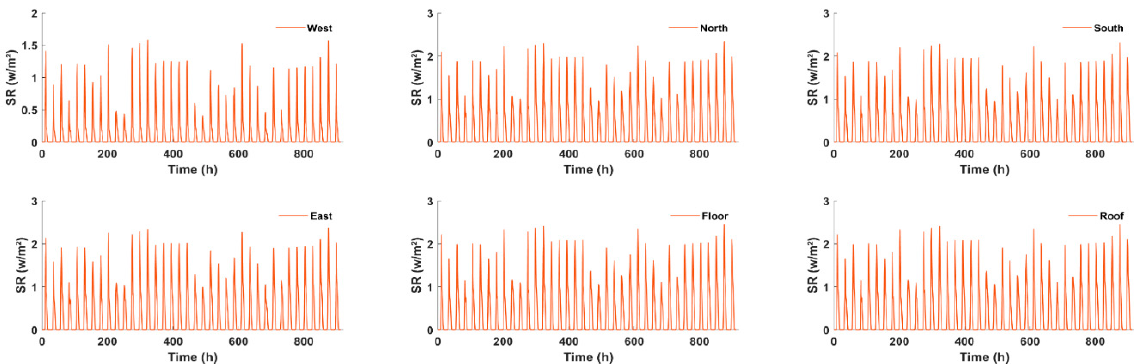
Figure 5. Internal solar radiation distribution inside the EEBLab among each wall.